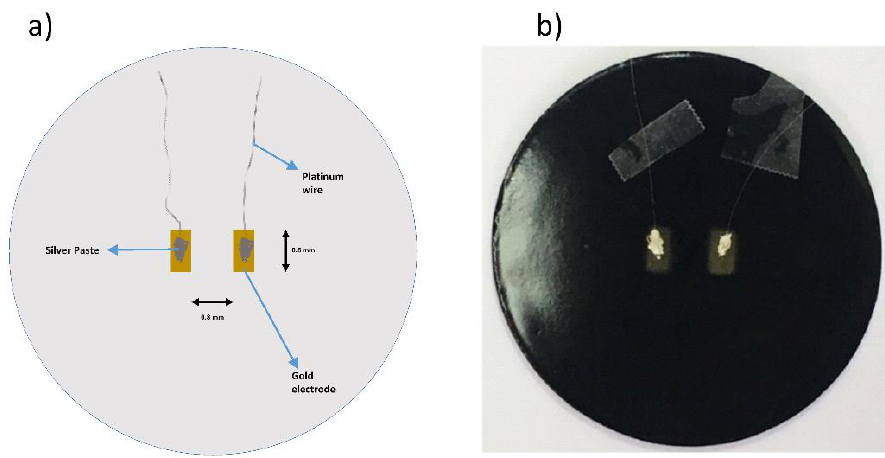
Figure 2. ( a ) The setup diagram for the electrical measurements ( b ) and a digital picture of the sample with the prepared setup.